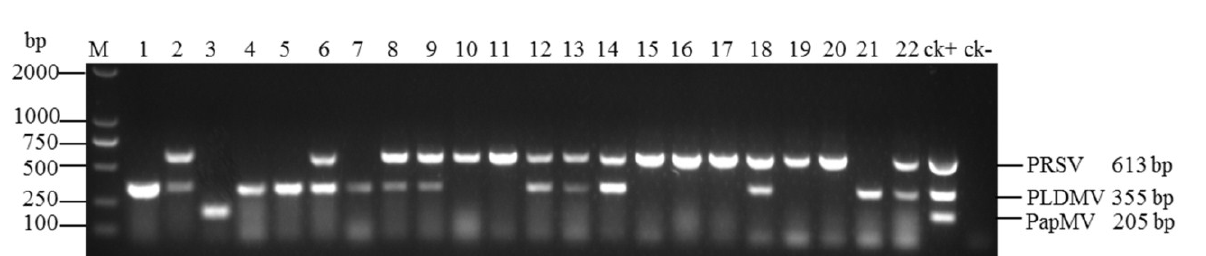
Figure 5. Agarose gel electrophoresis of 22 field samples collected from Hainan Island in plantations, kitchen gardens, and feral patches by multiplex RT-PCR. Various lanes show papaya plant infected with PRSV and PLDMV (Lanes 2, 6, 8, 9, 12, 13, 14, 18, and 22); PRSV (Lanes 10, 11, 15, 16, 17, 19, and 20); PLDMV (Lanes 1, 4, 5, 7, and 21); PapMV (Lane 3); Lane ck+: positive control, PRSV + PLDMV + PapMV. Lane ck-: health plants as a negative control. Lane M: DL2000 DNA